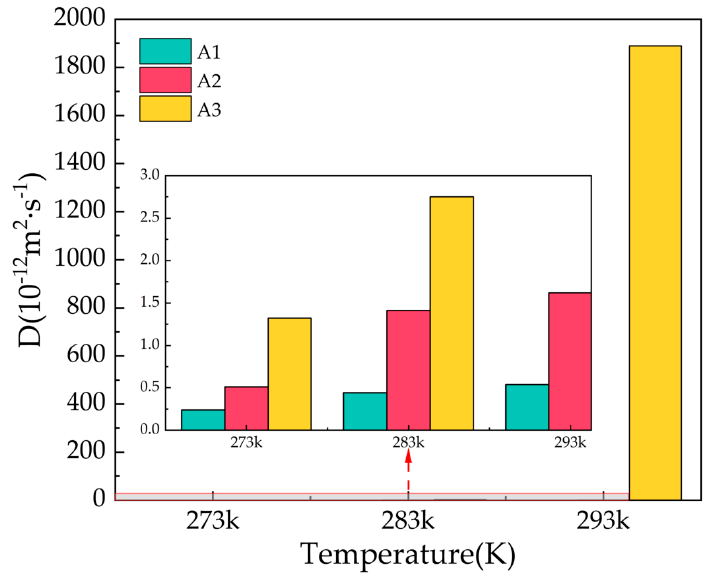
Figure 6. Diffusion coefficients of oxygen atoms in water molecules of A1, A2, and A3 model after 500 ps at P = 2 MPa and T = 273 K, 283 K, and 293 K. 500 ps at P = 2 MPa and T = 273 K, 283 K, and 293